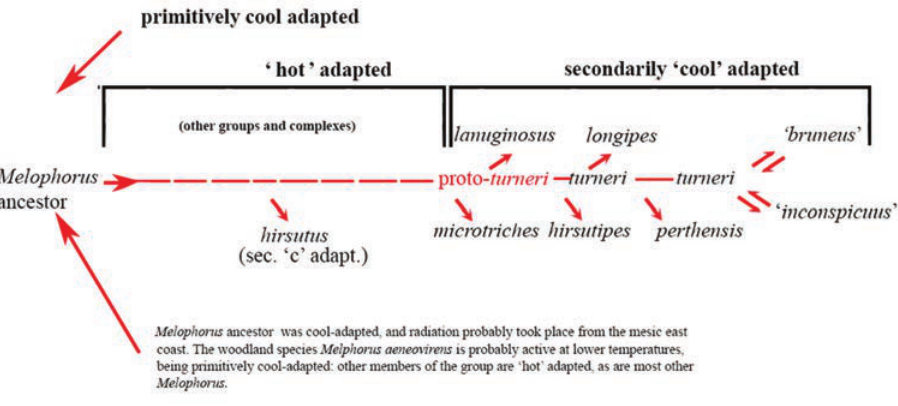
Figure 51. Speculative diagram depicting how cool–adapted foraging by Melophorus in the M . fieldi complex may have